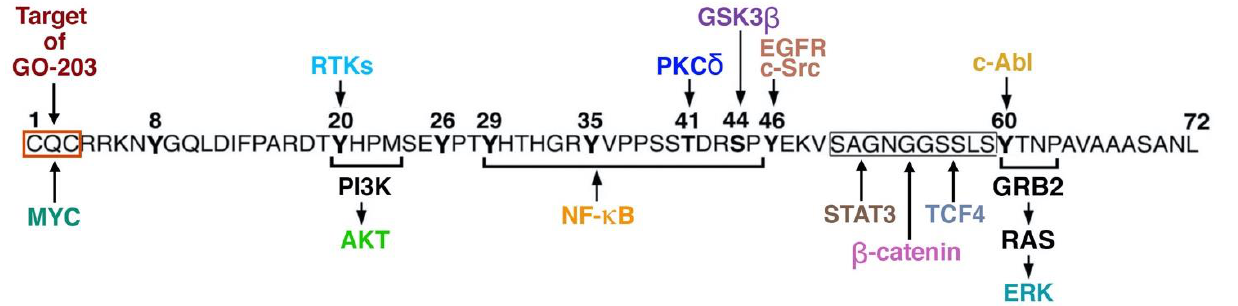
Figure 3. MUC1-C cytoplasmic domain interacts with diverse effectors of the CSC state. The MUC1- C CD (72 aa) is an intrinsically disordered protein that functions as a node in integrating multiple signaling pathways that promote the CSC state. MUC1-CD includes a CQC motif that is (i) a sensor of increases in ROS, (ii) necessary for the formation of MUC1-C homodimers and (iii) a target for the GO-203 inhibitor. The MUC1-CD CQC motif confers binding to MYC. Shown are tyrosine phosphorylation sites that function as motifs for interactions with PI3K (pYHPM) and GRB2 (pYTNP) in activating the AKT and ERK pathways, respectively. Also shown are potential consensus SH2 binding motifs for interactions with SHC (pYPTY) and PLC γ 1 (pYVPP). In addition, MUC1-CD interacts directly with proinflammatory TFs, such as NF- κ B and STAT3, and the WNT pathway effectors, β -catenin and TCF4, that are associated with driving the CSC state. Highlighted is the SAGNGGSSLS or SER-rich motif (SRM) that functions as a binding region for STAT3, β -catenin and TCF4. Figure modified from [57,98].